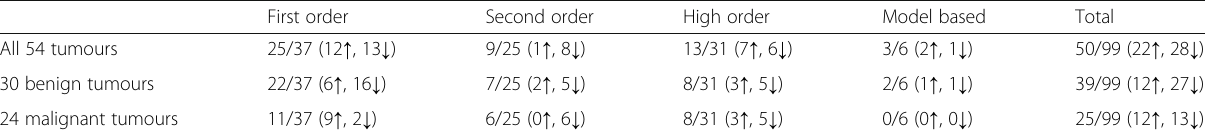
Table 2 Number of texture features that significantly changed ( p < 0.05), either increasing ( ↑ ) or decreasing ( ↓ ) between early and late scanning time